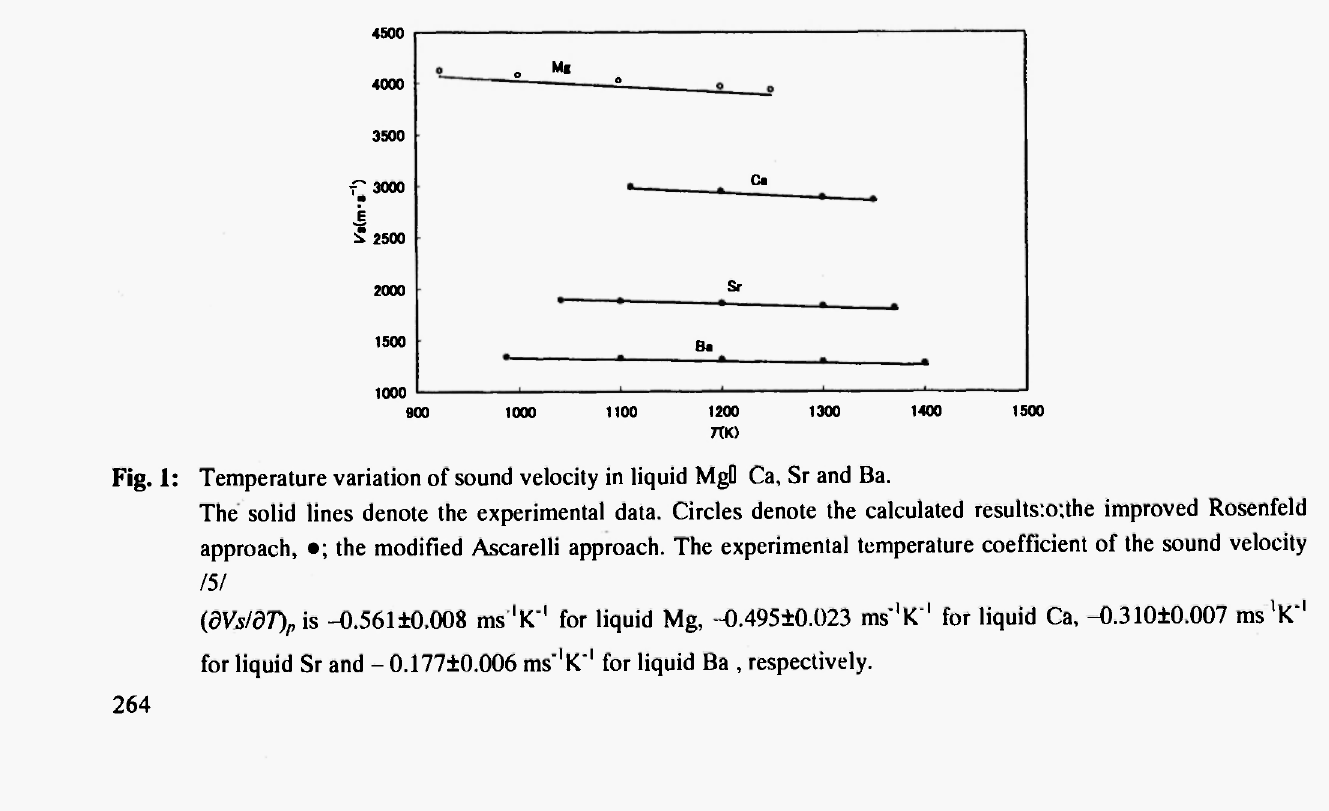
Input data of density(p) and sound velocity (Ks) results of liquid Mg (the improved Rosenfeld approach).Experimental data are taken from Ref./ 5 /. a P denotes the thermal expansion coefficient. Throughout this work (δΙησ/δΙηΤ), = - 0.063 is used irrespective of temperature. Τ : absolute temperature, ξ. packing fraction and σ. hard sphere diameter.